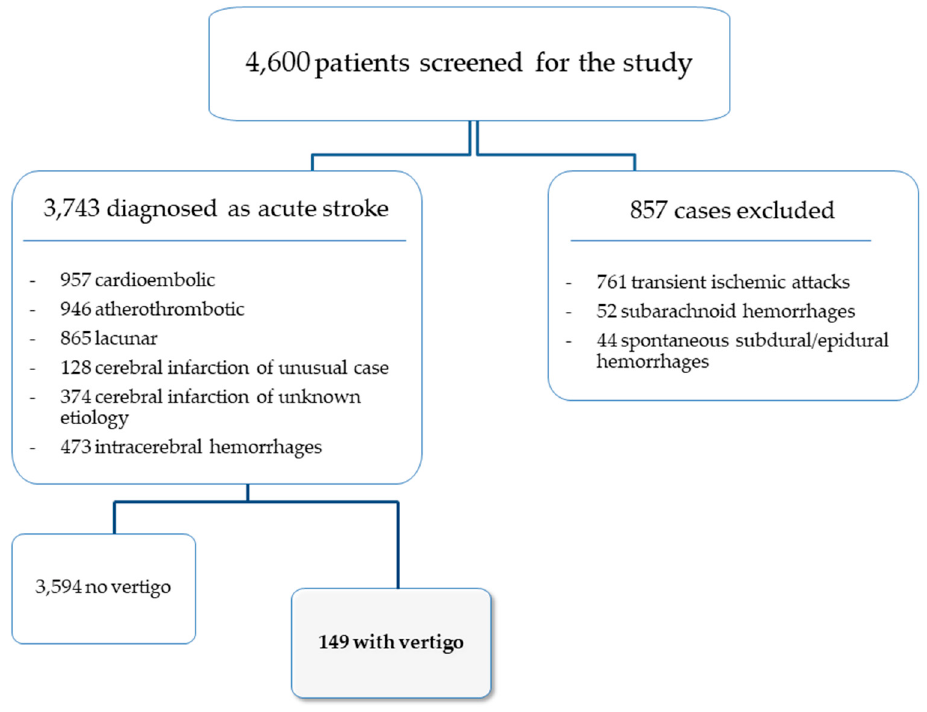
Figure 1. Flow-chart of patients included in the study.